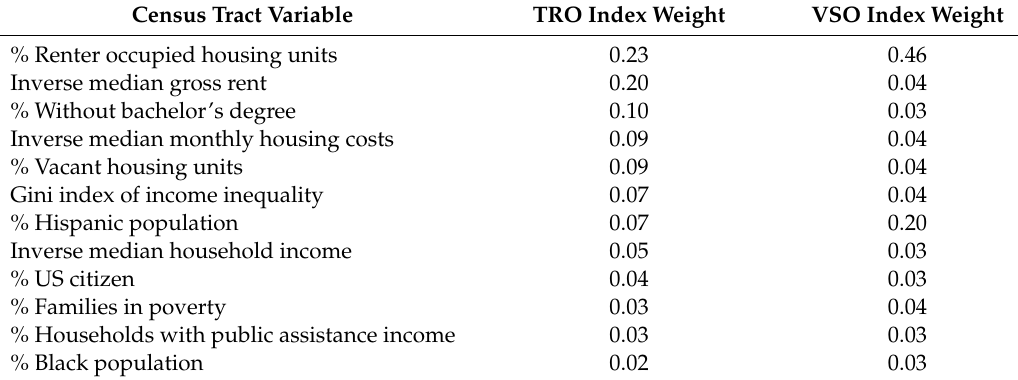
Table 2. Empirically estimated weights of variables in the Neighborhood Disadvantage Index for tobacco retail outlets and vape shop outlets in Virginia,